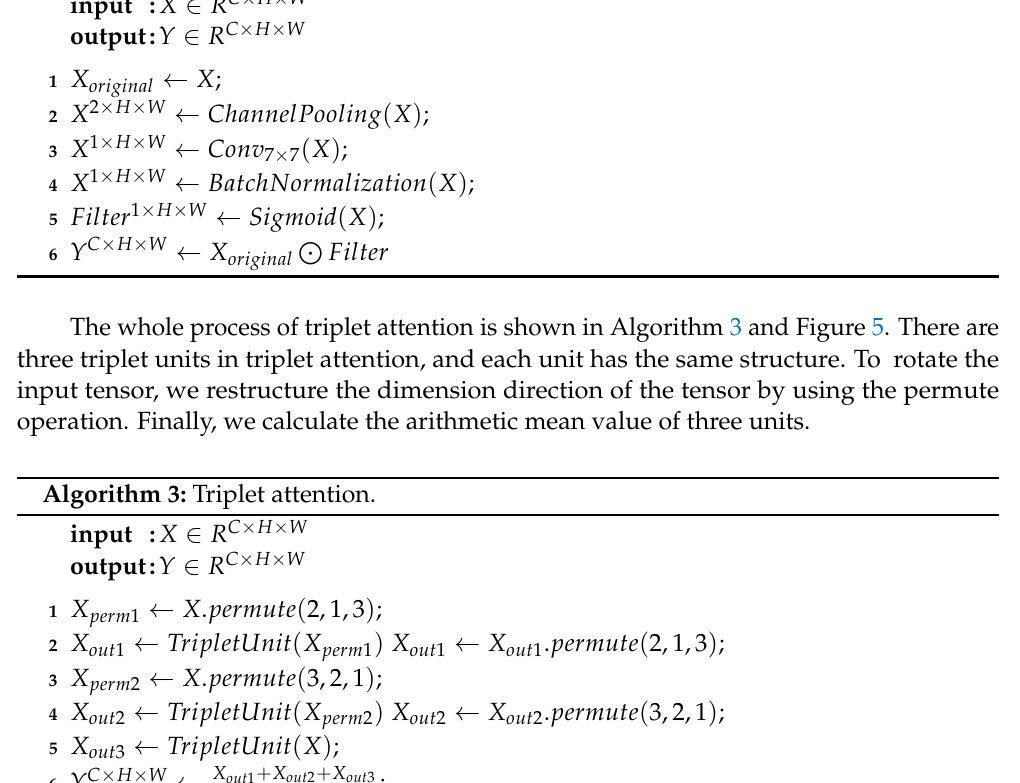
Algorithm 2: Triplet unit.